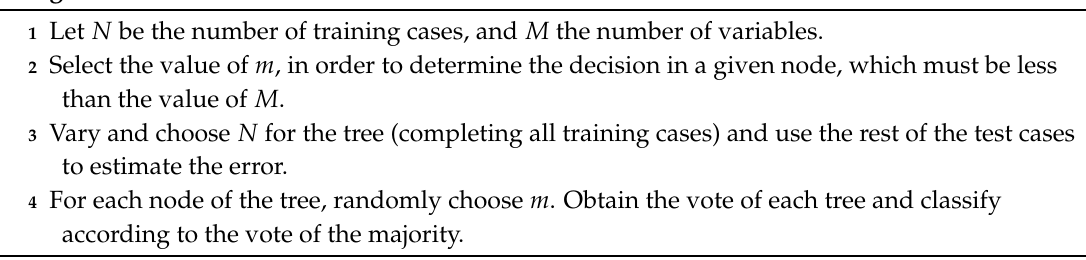
Algorithm 1: Random Forest for